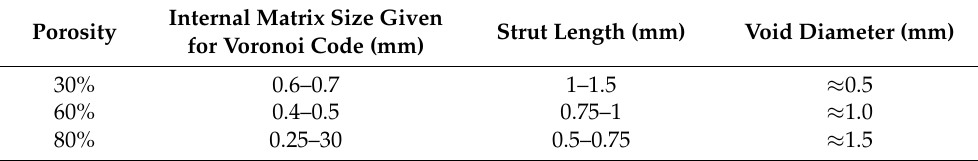
Input parameters of numerical computation for Voronoi tessellation method based open-cell foam.